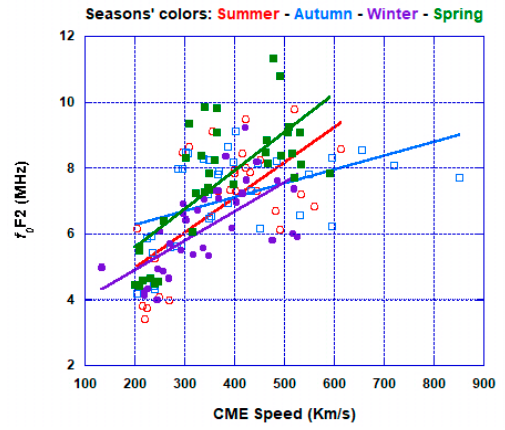
Figure 8. The seasonal variation of the monthly average f 0 F2 as a response to the monthly average